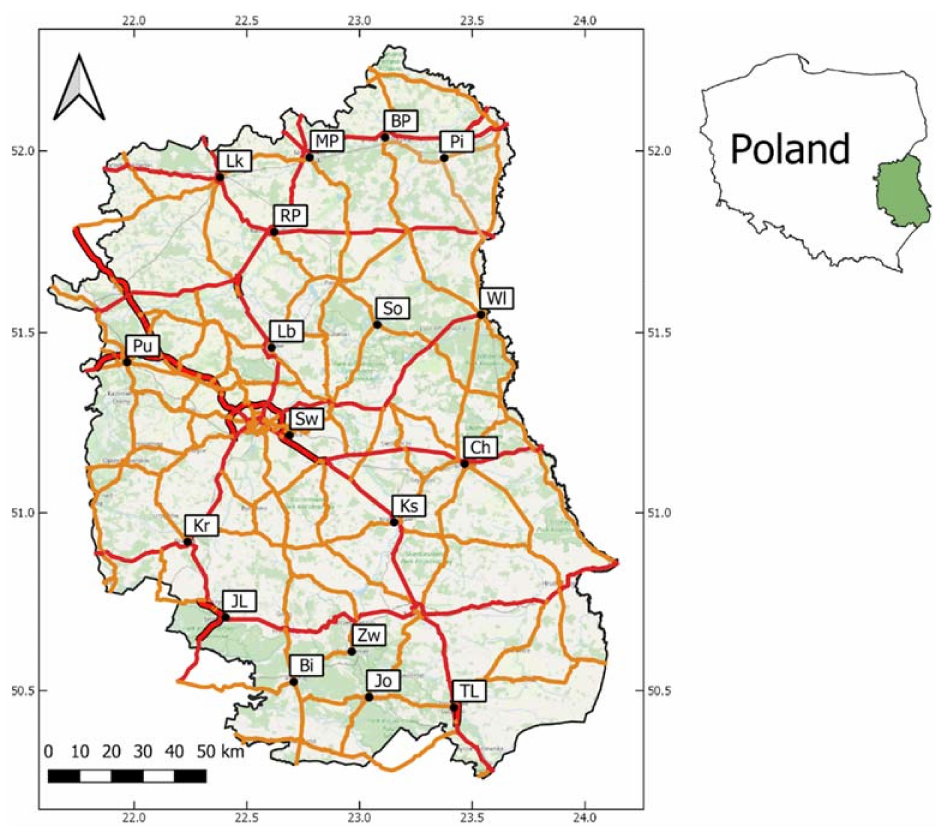
Figure 2. Locations of biomass depots and the network of main roads in Lubelskie Voivodeship.